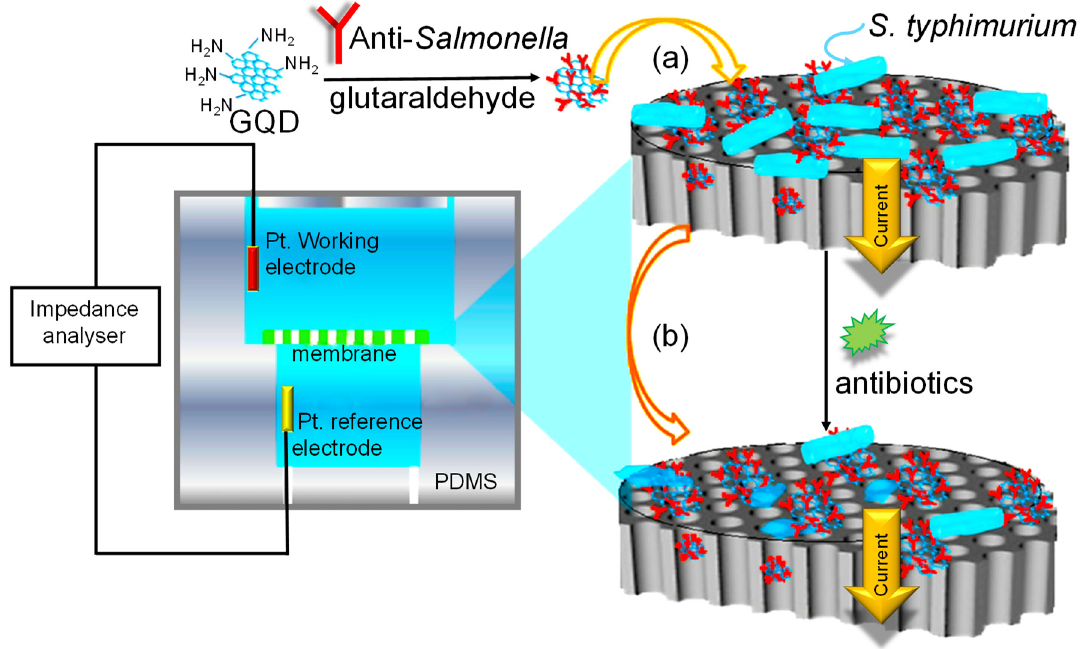
Figure 27. Detection of S. typhimurium by an impedimetric antibody sensor, followed by its response towards antibiotics, where ( a ) increased impedance ( b ) decreased impedance [79].